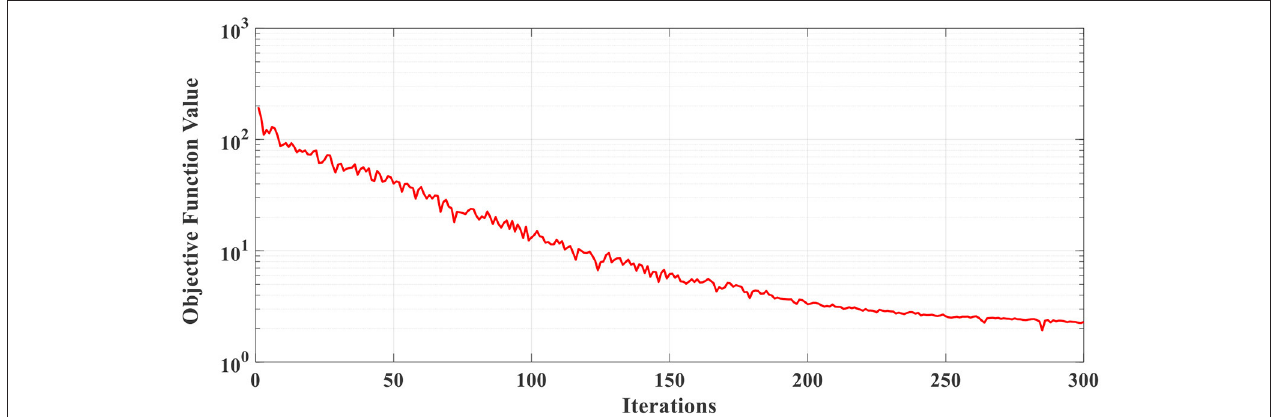
FIGURE 11 | Objective function values diagram of intermediate pressure turbine.